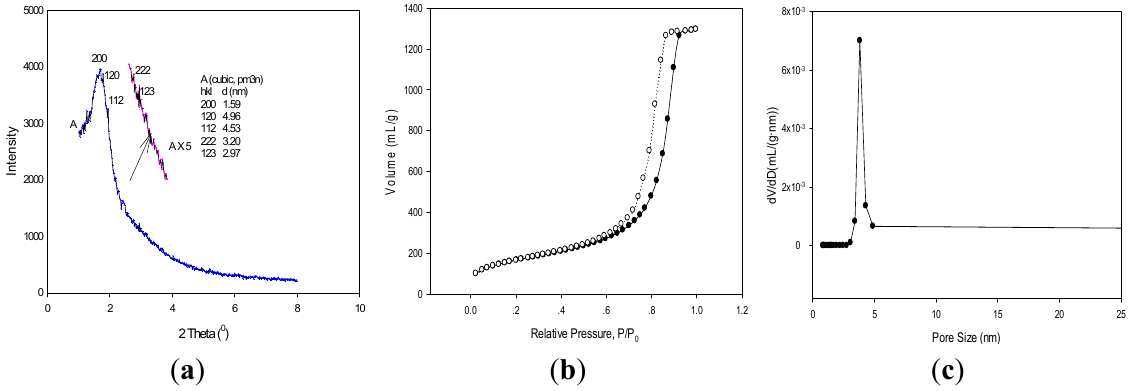
Figure 1. Small-angle X-ray diffraction (XRD) ( a ) nitrogen adsorption-desorption, ( b ) and pore size distribution ( c ) of the cubic Pm3n Hexylene-bridged periodic mesoporous polysilsesquioxanes (HBPMS). hkl: miller